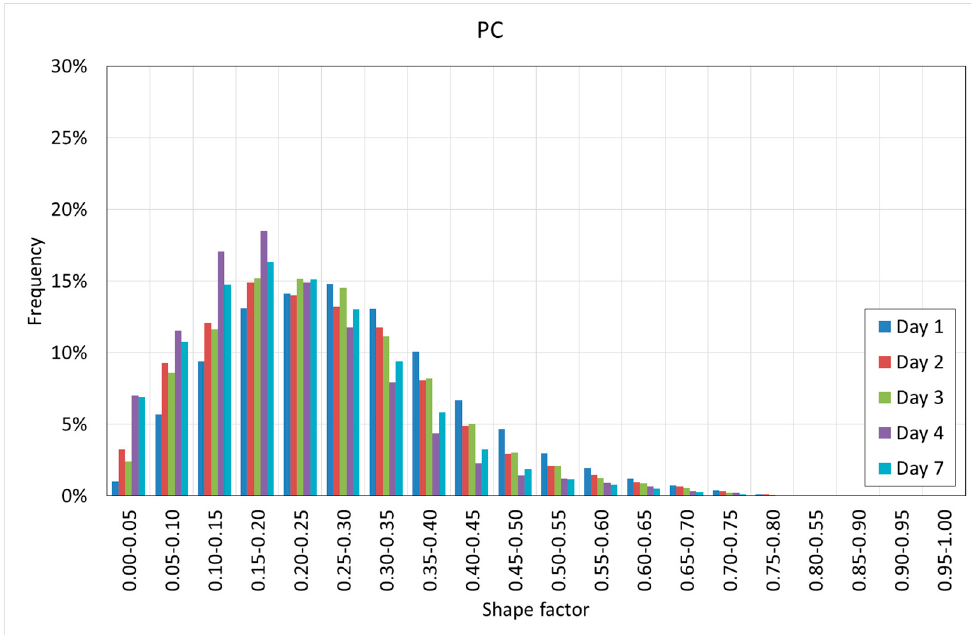
Figure 20. Histogram of the shape factor of SFRC.